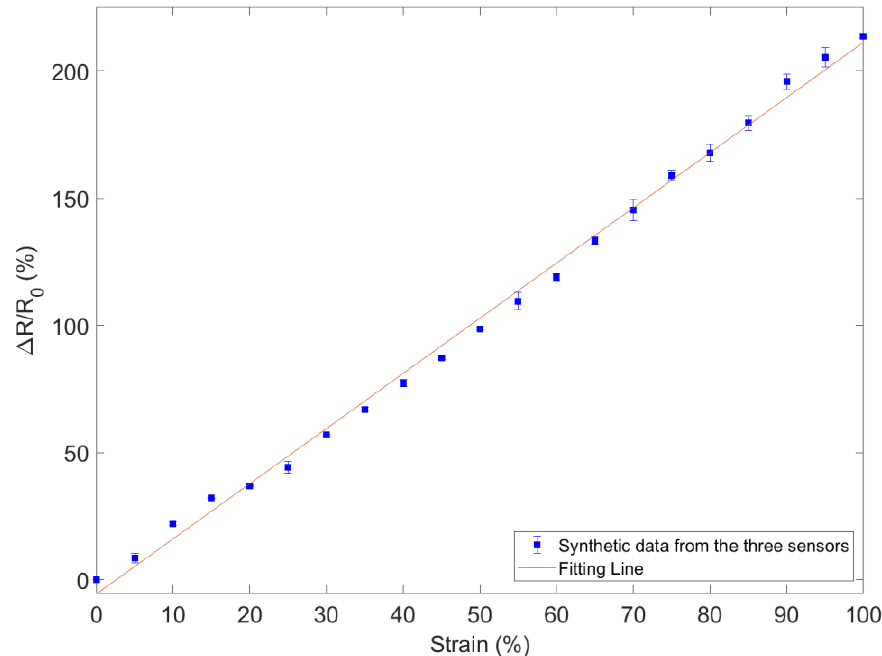
Figure 5. Average response of the three stretch sensors according to the elongation. The points are the average values of the three sensors (see Figure 4) and the error bars are the response variability of the three sensors. The line is the line of best fit for the measurement points.